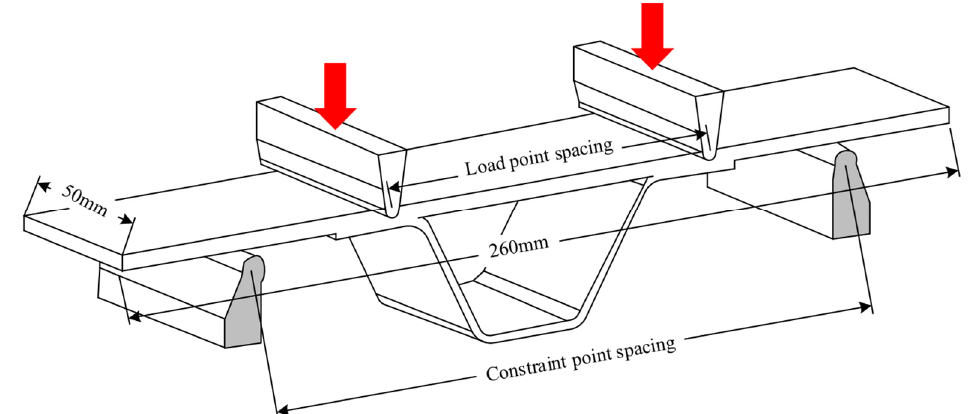
Figure 6. Schematic diagram of the four-point bending loading.